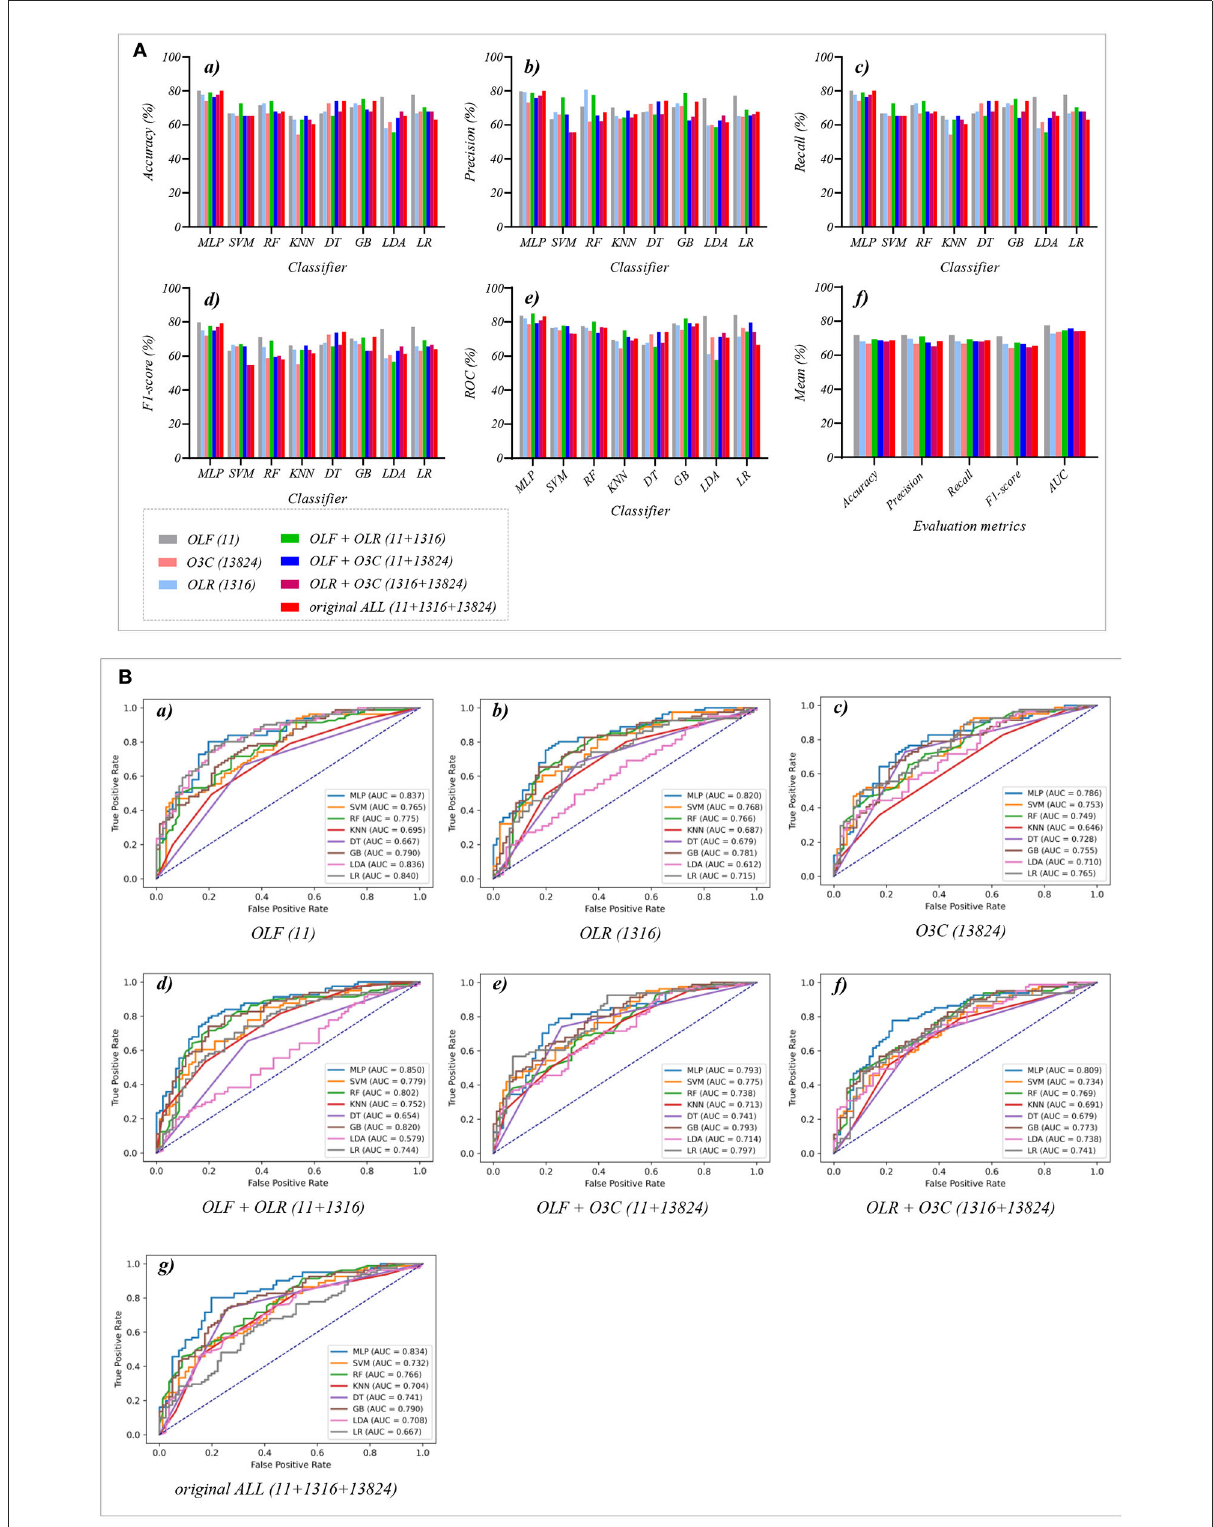
FIGURE4 The evaluation metrics pictures and ROCs of eight classifiers with seven original classification features (three original features and four original combination features in Experiment 1). (A) The evaluation metrics pictures include (a) Accuracy, (b) Precision, (c) Recall, (d) F1-score, (e) AUC, and (f) Mean. (B) ROCs of the ML classifiers include (a) OLF (11), (b) OLR (1,316), (c) O3C (13,824), (d) OLF (11 13,824), (f) OLR O3C (1,316 13,824), (g) OLF OLR O3C (11 1,316 + + + + + + +